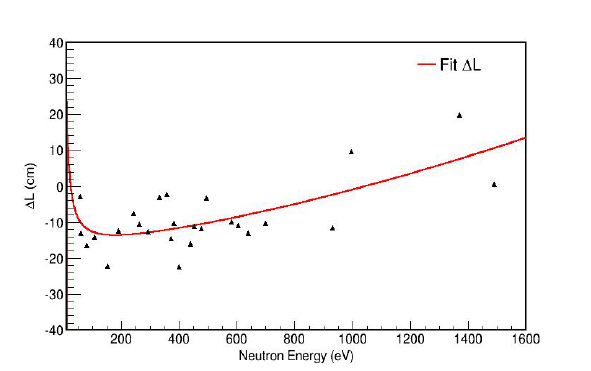
Fig.10 The ΔL at the resonance energies of the 197 Au sample. The red solid line is the fitting results with Eq.8.